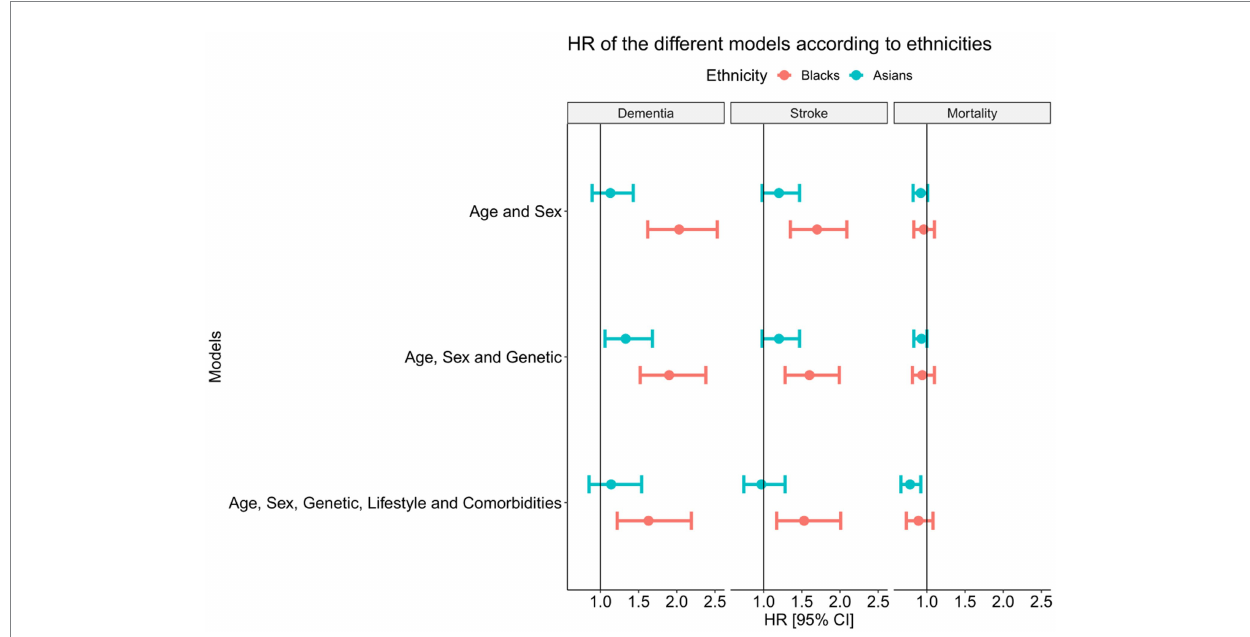
FIGURE 4 Hazard ratios and 95%CIs for the risk of dementia, stroke and mortality according to ethnicity. Whites are used as the reference